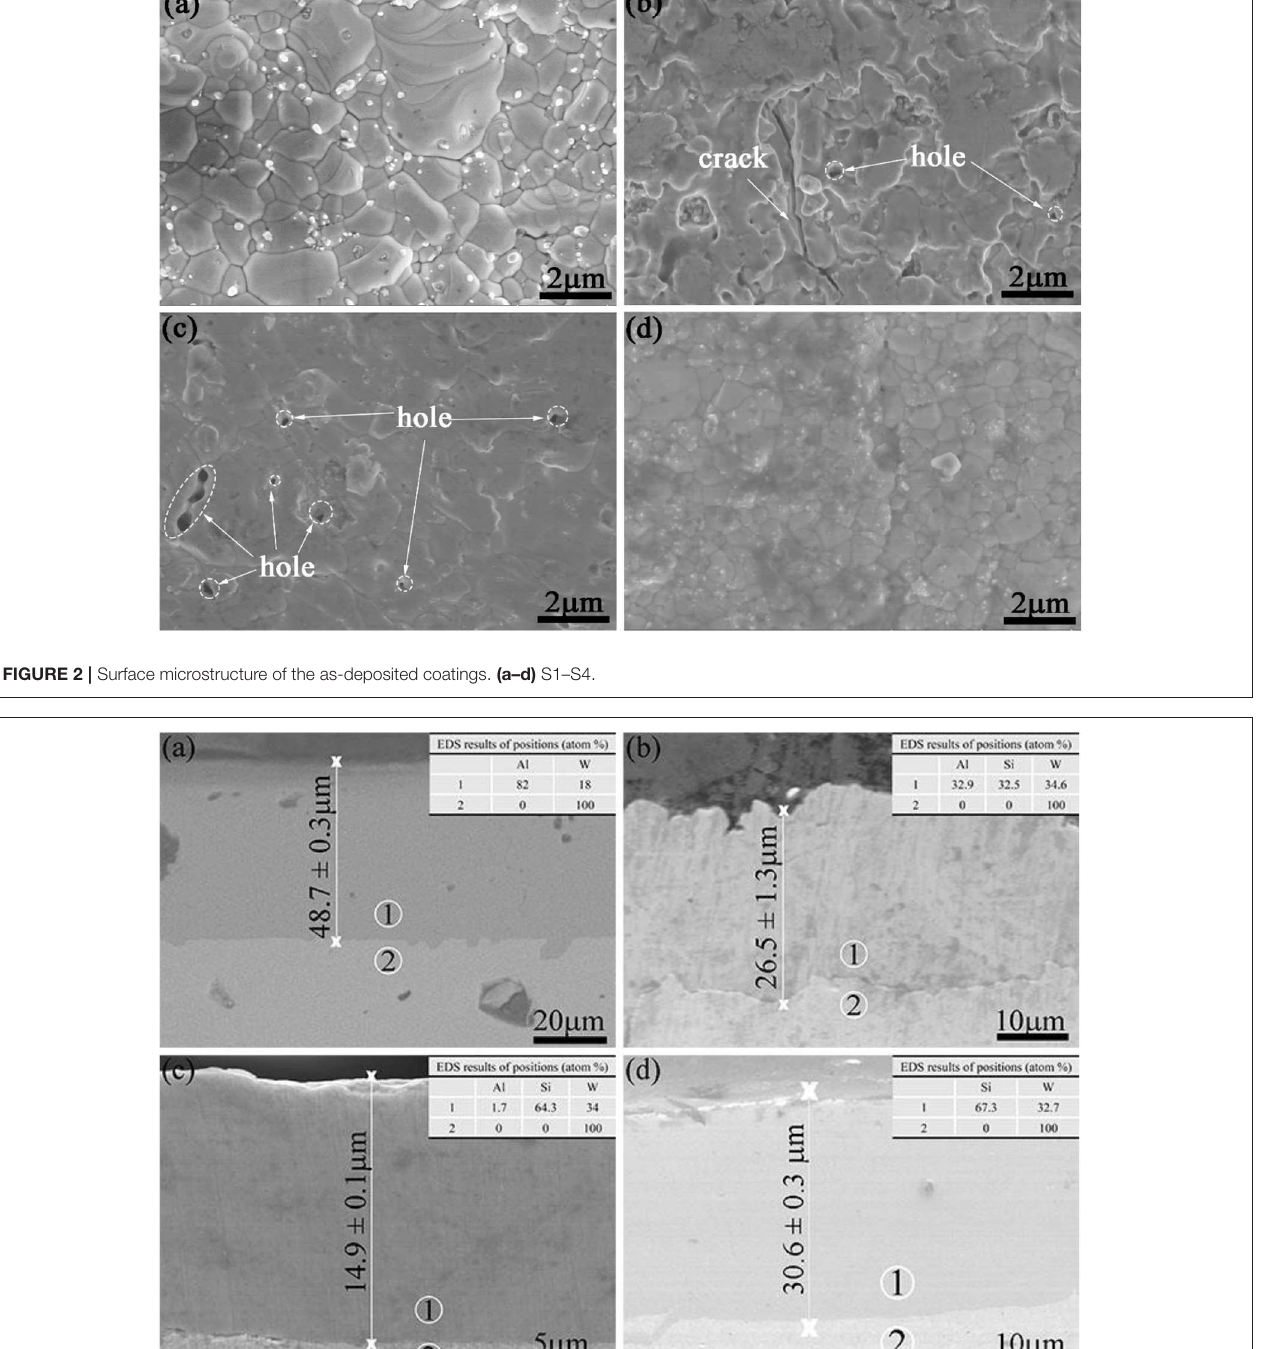
Frontiers in Materials |